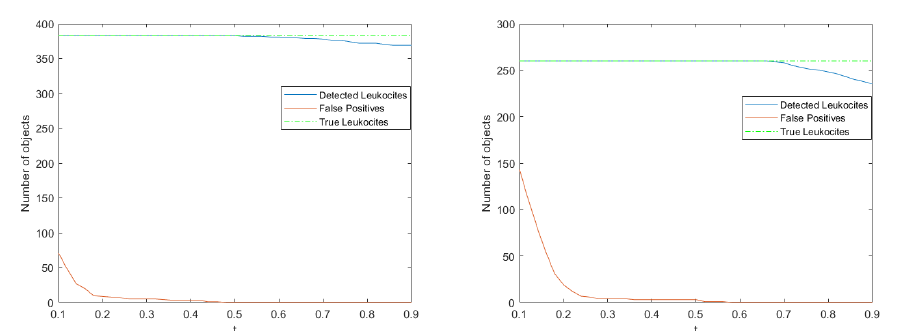
Figure 14. WBCs detection performances on SMC-IDB and IUMS-IDB, respectively. They are close (or equal) to 100% if t value lies in the range [0.4–0.6].